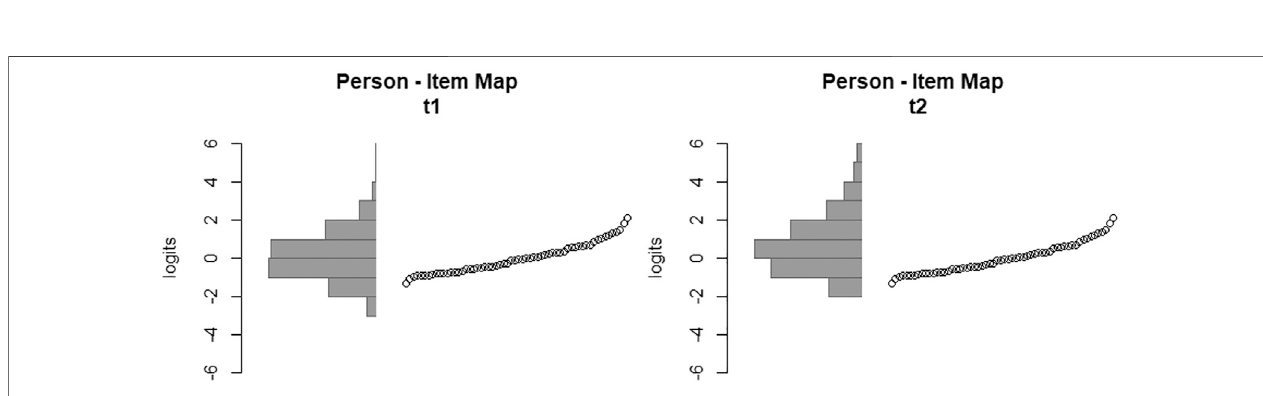
FIGURE 2 | Graphical Model Check by different split criteria (60 items). Note. The blue ellipsoid represents the items ’ standard errors computed by repeated subsampling ( k (cid:1) 30). The centers ofthe ellipsoids are given by the item parameters in both groups. An intersection of the ellipsoid and the bisecting angle indicates that there is no difference between the splits.